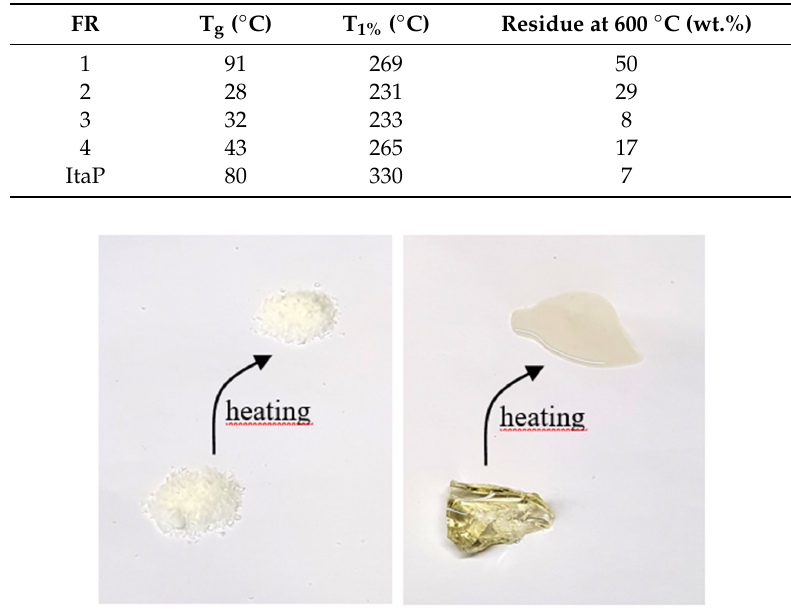
Figure 3. FR 1 (left) and FR 2 (right) before (bottom) and after (top) heating. FR 3 and FR 4 behave under heat like FR 2. Table 1. Tg, T 1% and Residue of FR 1–4 and ItaP obtained by DSC and TGA with a heating rate of 10 K min −1 in nitrogen atmosphere.